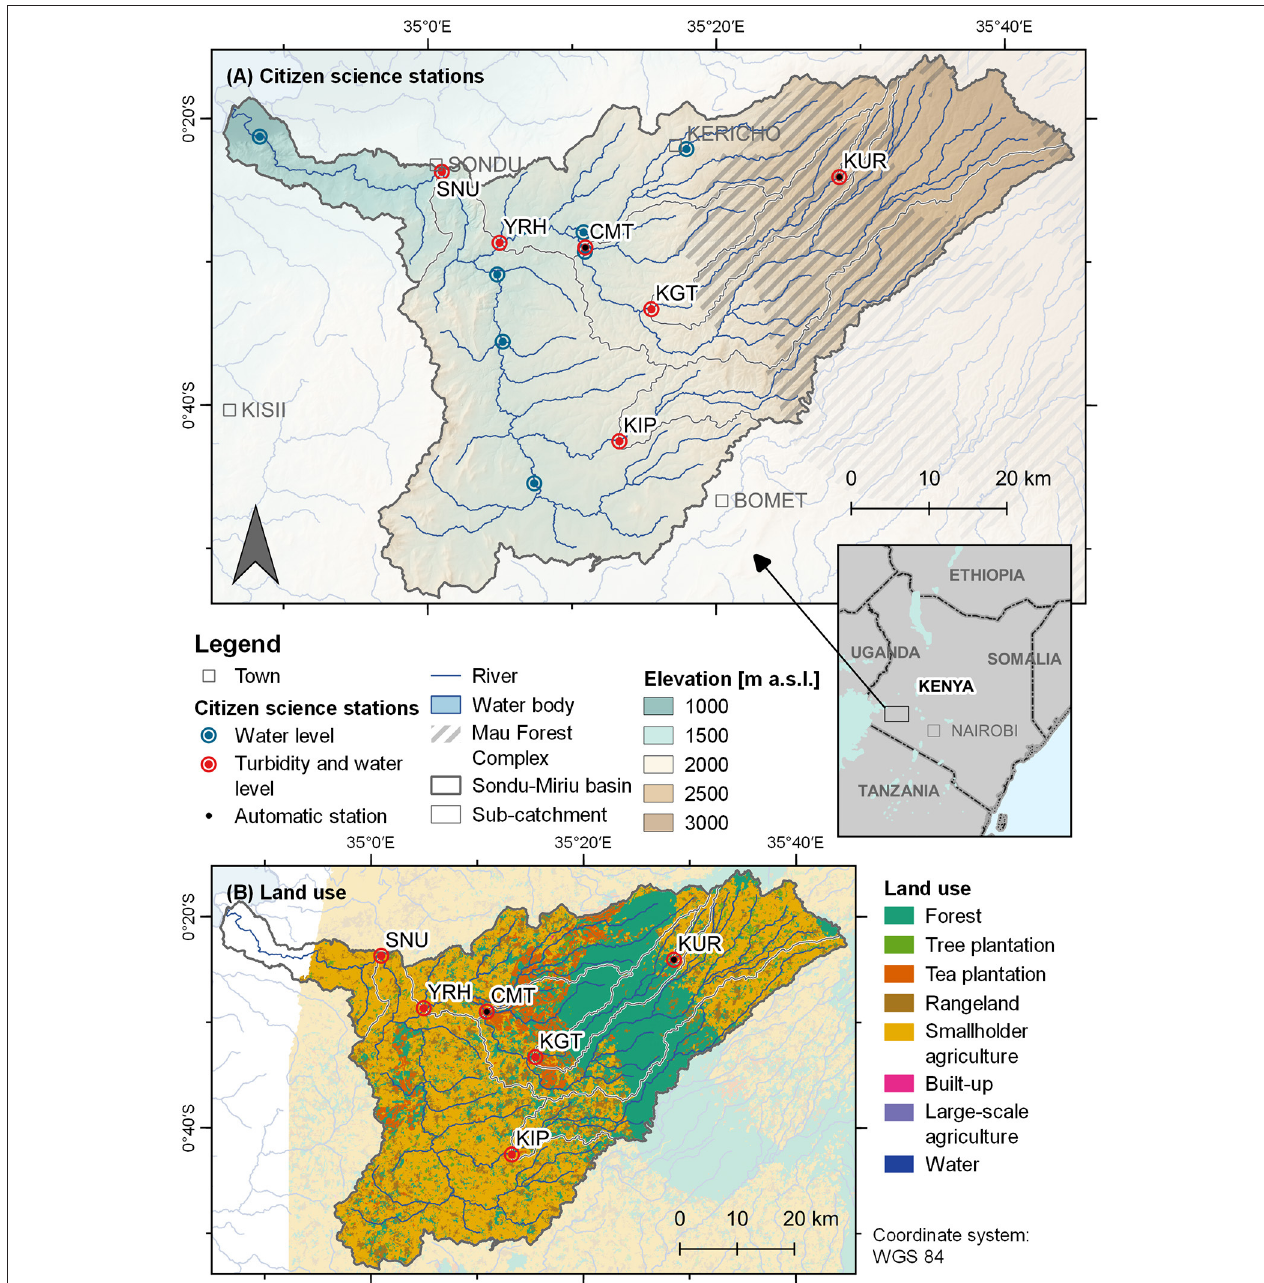
FIGURE 1 | Map of the study area showing (A) elevation (SRTM digital elevation model 30m resolution; USGS, 2000), citizen science stations and automatic water monitoring network and (B) land use within the Sondu-Miriu River